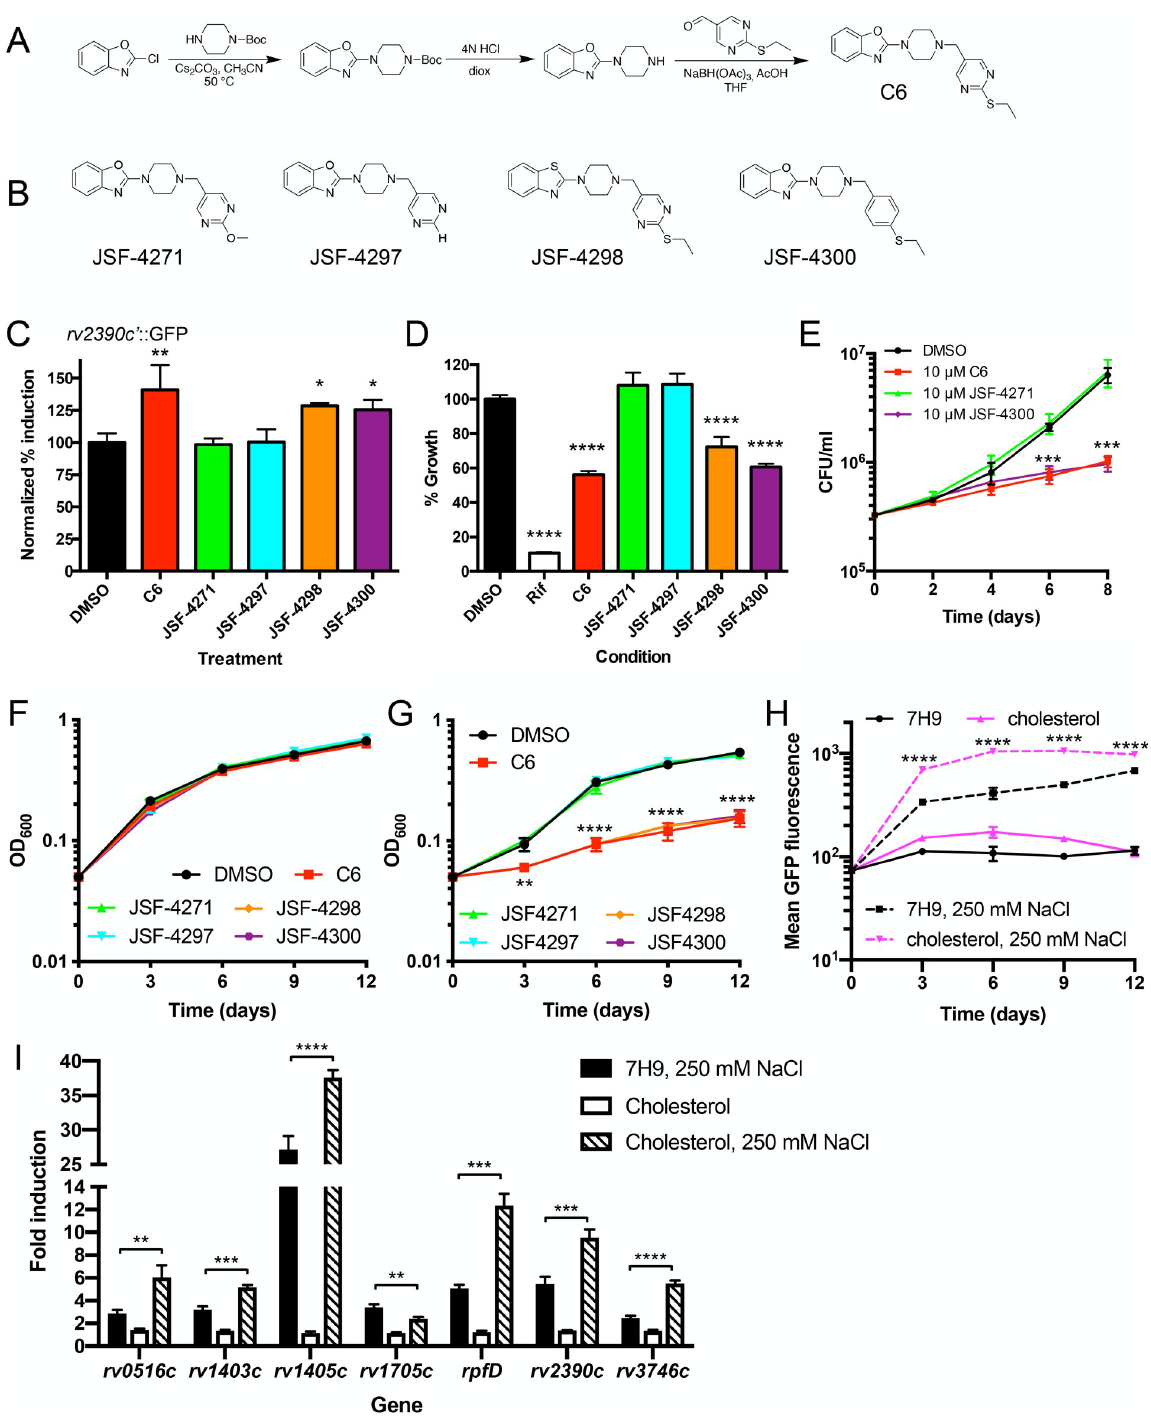
Fig 2. SAR analysis reveals that the chloride response phenotype of C6 tracks with inhibition of Mtb growth in macrophages. (A) Schematic for synthesis of C6. (B) Structures of C6 analogs synthesized. (C–E) C6 analogs that lose the ability to increase Mtb response to high [Cl − ] also lose the Mtb growth inhibition phenotype in J774 cells and primary BMDMs. (C) The rv2390c 0 ::GFP reporter Mtb strain was grown in 7H9 (pH 7) ± 250 mM NaCl and treated with DMSO, 10 μ M C6, or 10 μ M C6 analogs (JSF-4271, JSF-4297, JSF-4298, or JSF-4300) for 9 days and samples fixed and reporter GFP induction analyzed by flow cytometry. Data are shown as means ± SD from 3 independent experiments. p - values were obtained with a one-way ANOVA with a Dunnett multiple corrections test, and treatment sets compared to the DMSO control. � p < 0.05, �� p < 0.01. (D) J774 macrophage-like cells were infected with Mtb constitutively expressing mKO and treated with DMSO, 5 μ M